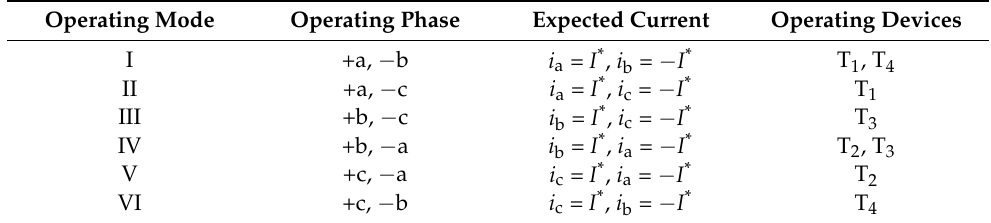
Table 1. The operating mode of BLDCM driven by FSTPI.